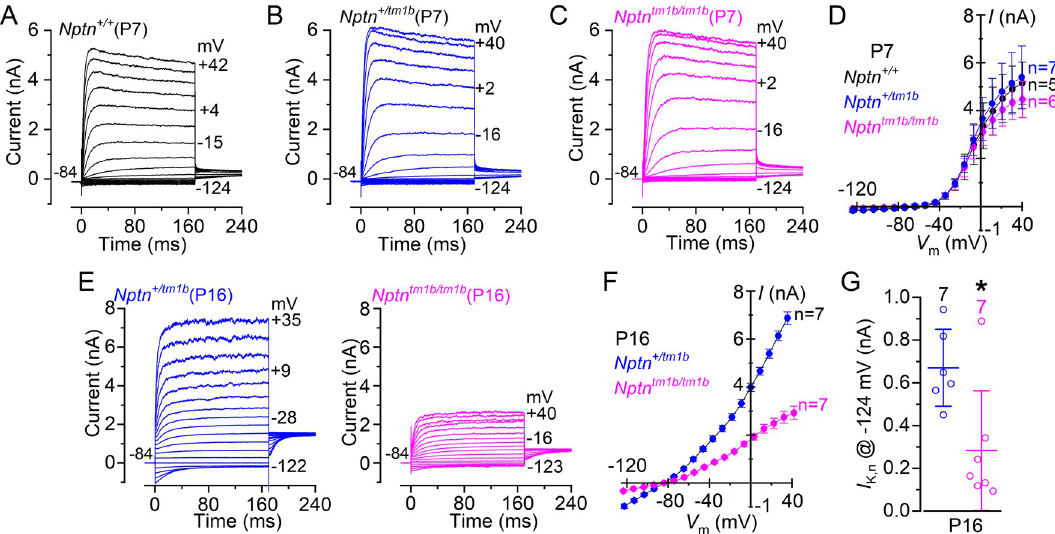
Fig 4. The development of OHCs is disrupted in Nptn tm1b mice. (A-C) Current responses from OHCs of control (A: Nptn +/+ ) heterozygous (B: Nptn +/tm1b ) and homozygous (C: Nptn tm1b/tm1b ) mice at P7, which is during pre-hearing ages. Current recordings were elicited by using depolarising and hyperpolarising voltage steps (10 mV increments) from the holding potential of –84 mV to the various test potentials shown by some of the traces. (D) Steady-state current-voltage curves obtained from P7 OHCs from the three genotypes. (E) Current responses from mature OHCs of Nptn +/tm1b (left) and Nptn tm1b/tm1b (right) mice at P16. Note that the time- course of the currents are comparable between the two genotypes, although the current is largely reduced in the Nptn tm1b/tm1b mouse. (F) Steady-state current-voltage curves obtained from P16 OHCs from the two genotypes. (G) Size of I K , n measured as the difference between the peak and steady-state of the deactivating inward current at –124 mV [21]. The number of IHCs recorded are shown above each column. Average data are plotted as mean ±